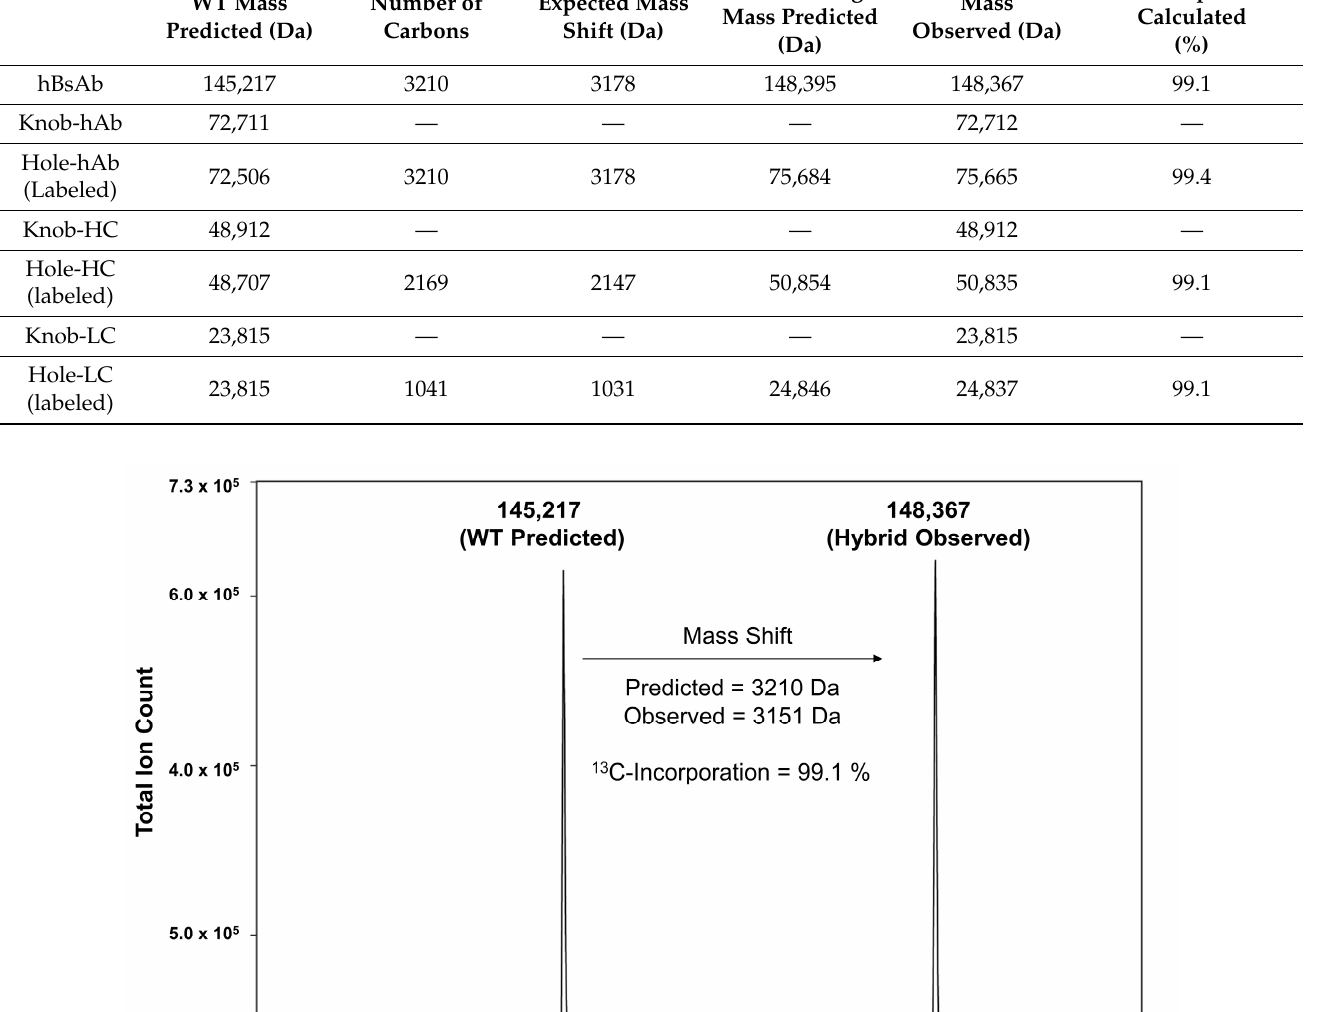
Table 1. Mass spectrometry analysis and determination of % 13 C-incorporation.